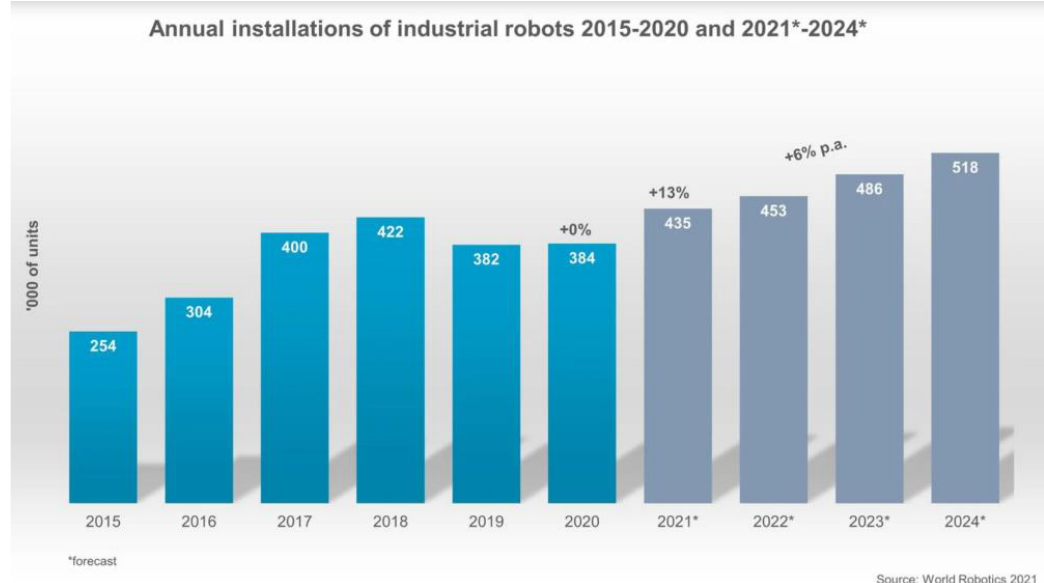
Figure 3. History and plans of the growth of robotization in the context of the use of vision systems by industry [54].